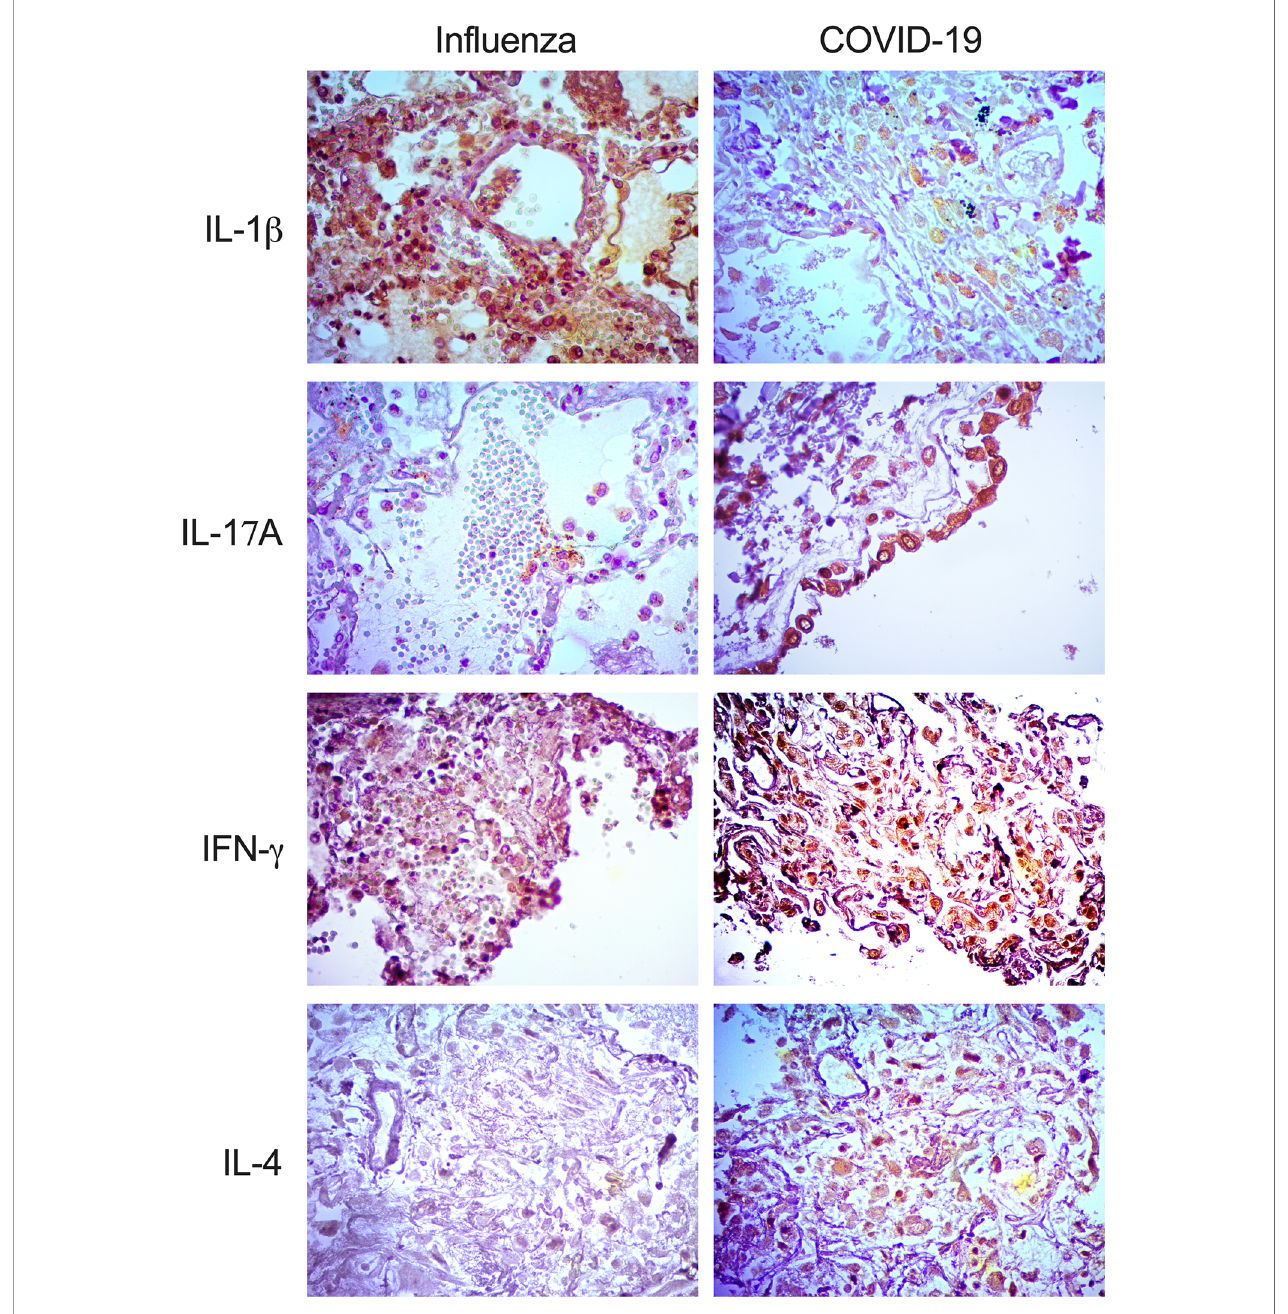
FIGURE 3 | Expression of immune markers in the lungs of pandemic in fl uenza A(H1N1) and COVID-19 patients. Expression of different immune markers in lung autopsy specimens from pandemic in fl uenza A(H1N1) and COVID-19 patients was assessed using speci fi c antibodies by immunohistochemistry (IHQ),